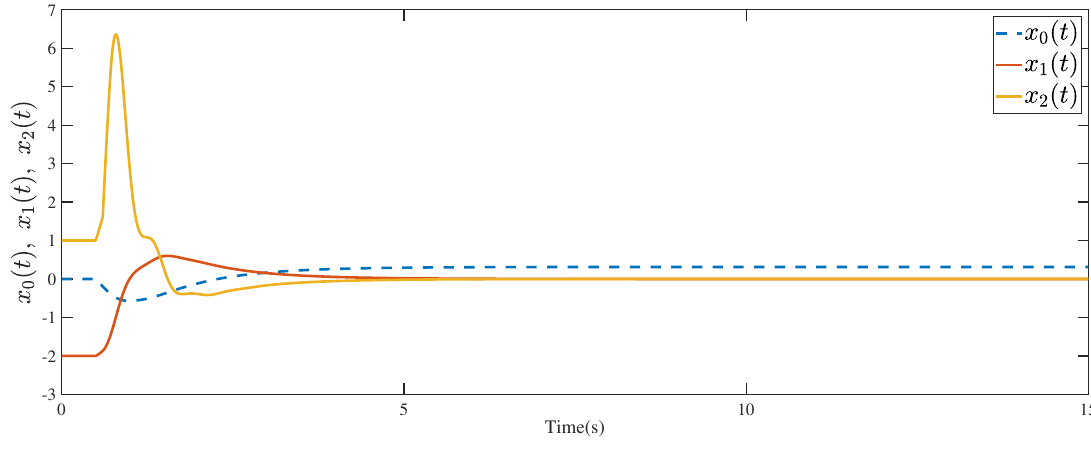
Figure 1. Trajectories of the states of system